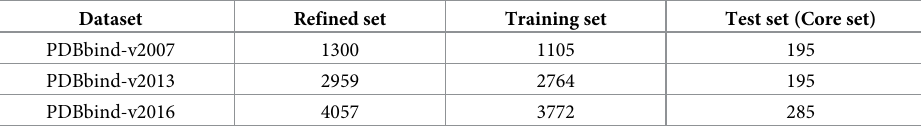
Table 1. Detailed information of the three PDBbind databases, i.e., PDBbind-v2007, PDBbind-v2013 and PDBbind-v2016. Dataset Refined set Training set Test set (Core